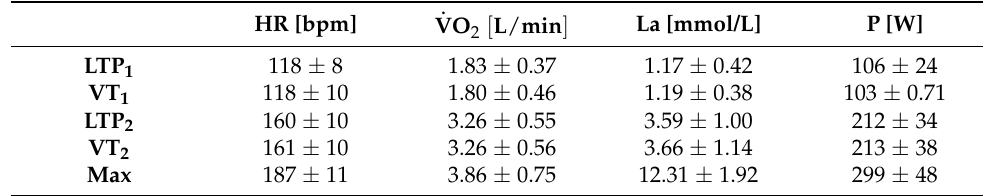
. Table 1. Heart rate (HR), oxygen uptake ( VO 2 ), lactate (La), and power output (P) at the first and second lactate (LTP 1 and LTP 2 ) and ventilatory thresholds (VT 1 and VT 2 ) as well as maximal values from the incremental cycle ergometer